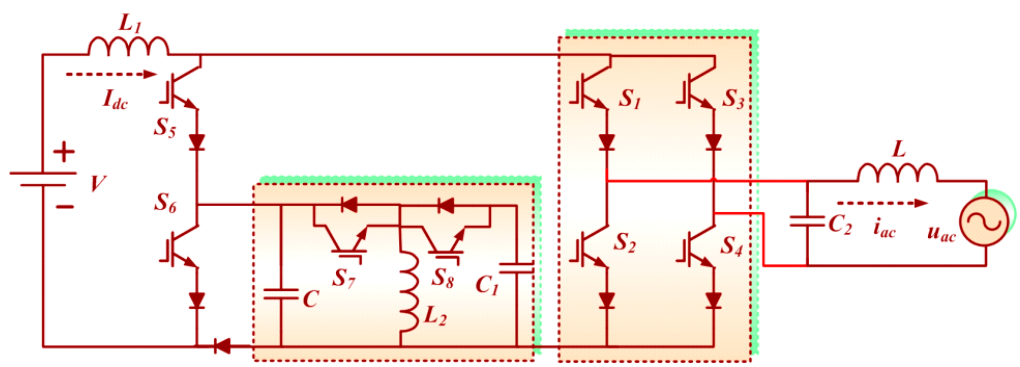
Figure 7. Power decoupling solution in [34].